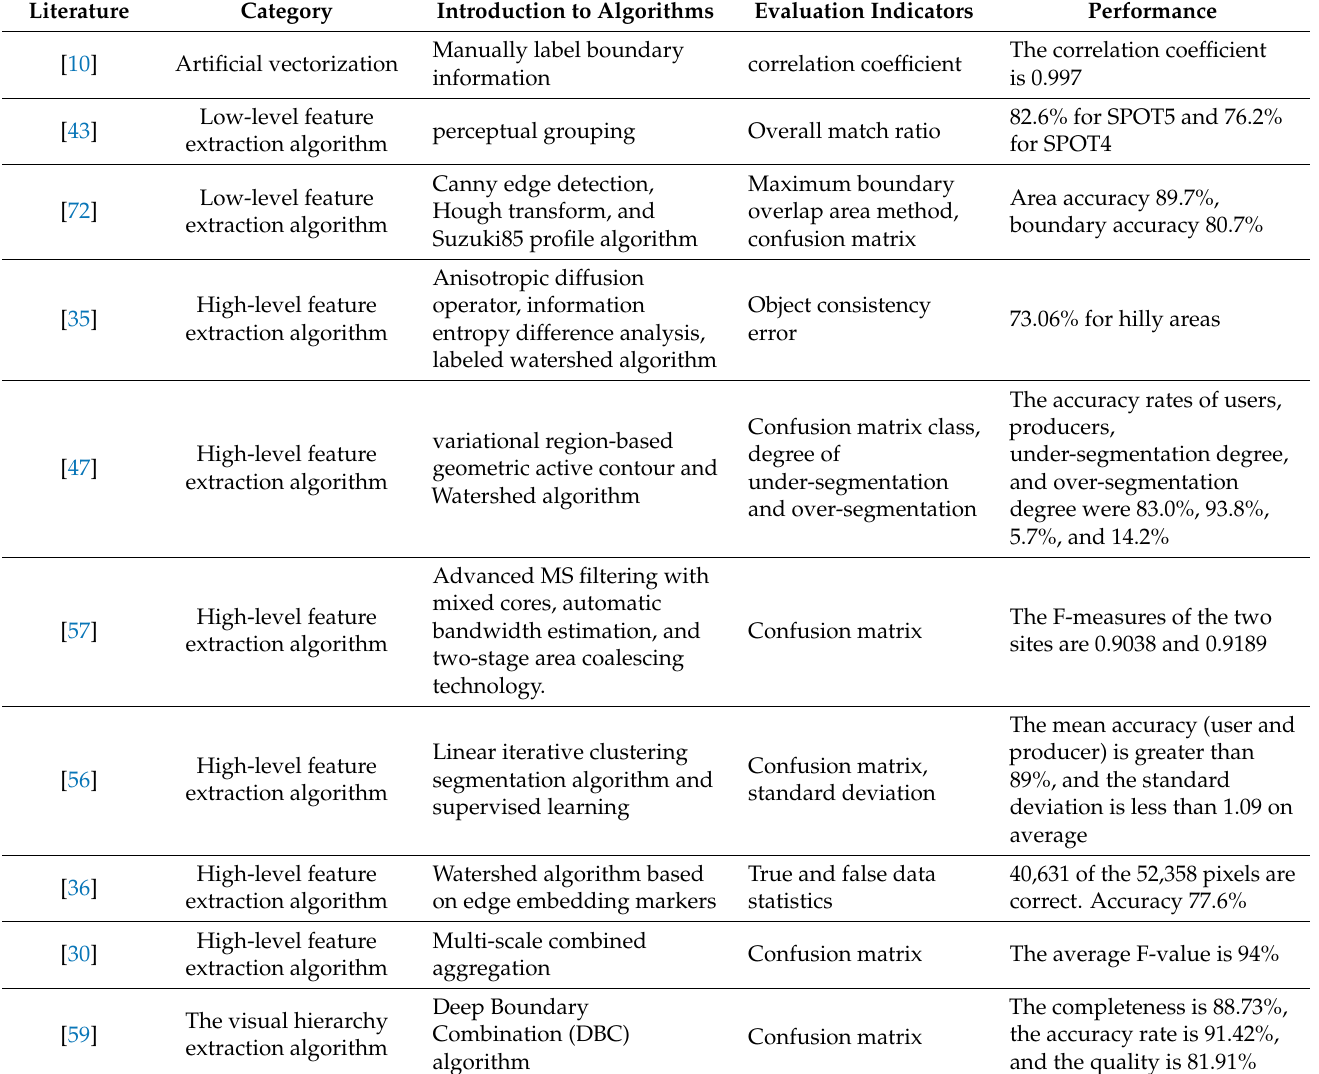
Table 10. Research, categories, introductions, evaluation indicators, and performances of boundary extraction